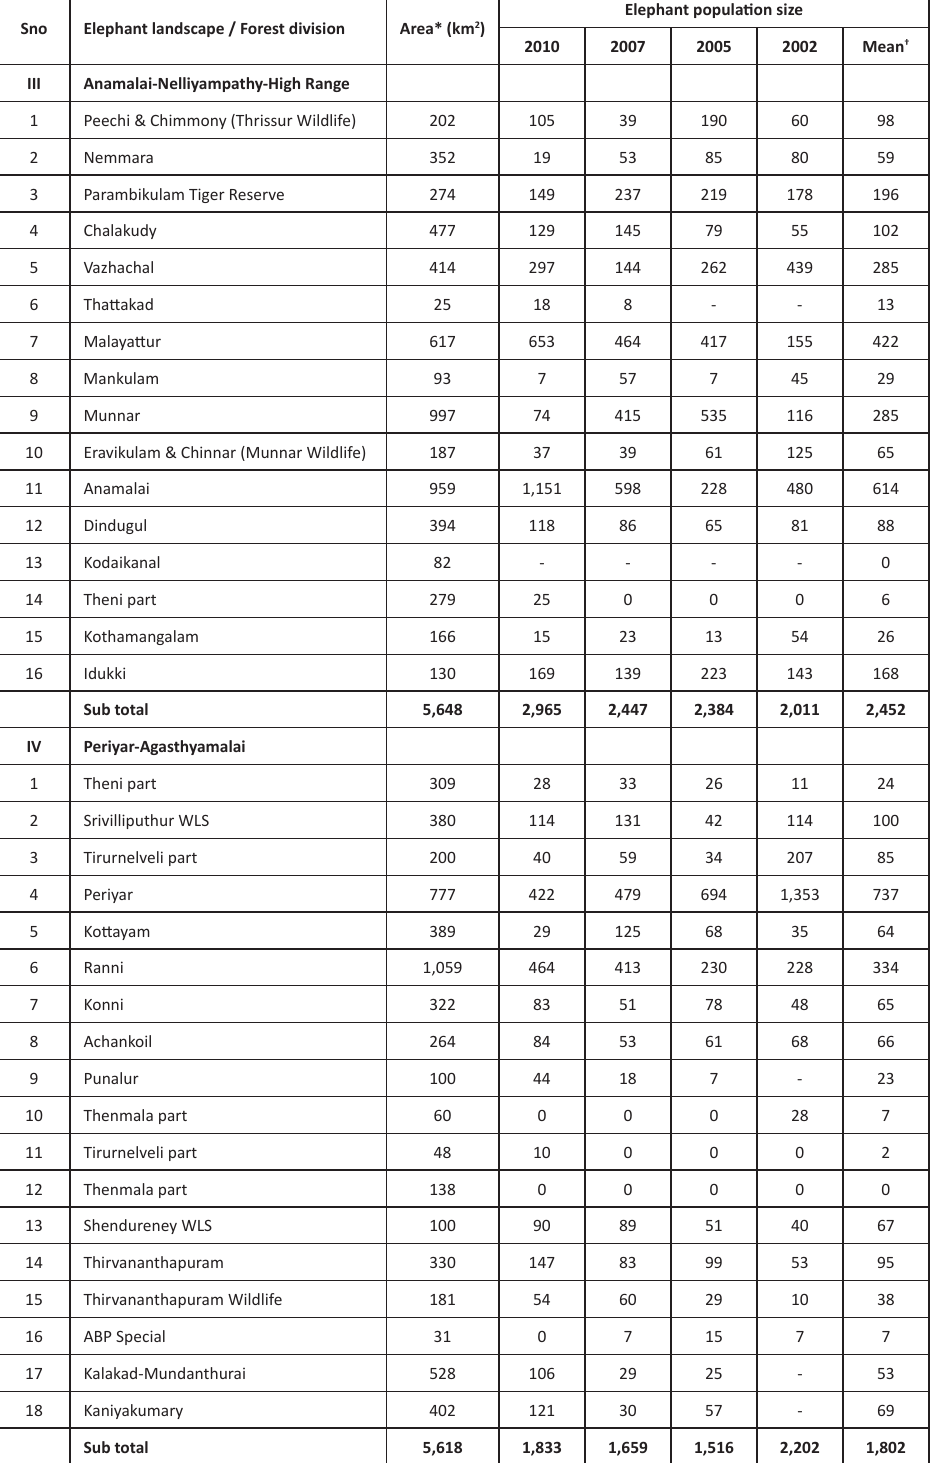
Table 4. Elephant population in the Western Ghats, south of Palghat